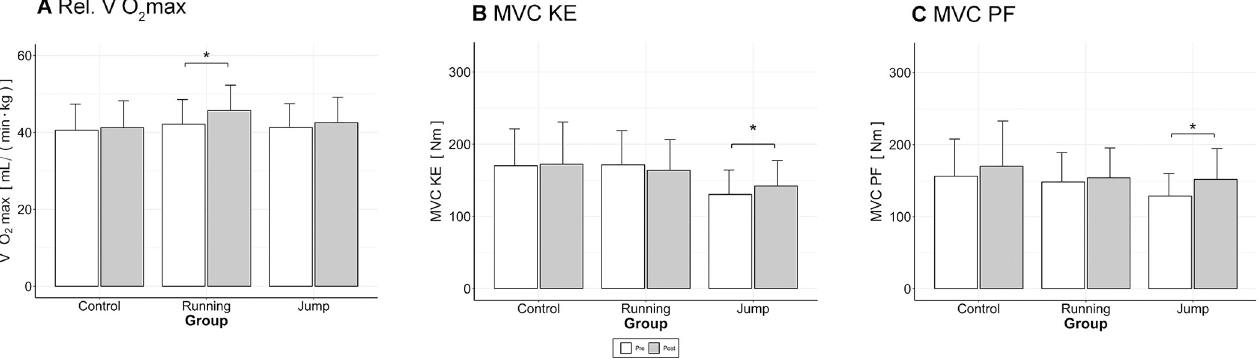
Fig 3. Changes in aerobic capacity as well as lower extremity strength. Results of the pre-tests in white, and post-tests in grey; data refer to group mean and SD. (A) relative _ V _ O , (B) Maximal voluntary contraction (MVC) during knee extension (KE), (C) MVC during plantar flexion (PF). The � symbols denote 2 max significant differences between pre-and post-values (Bonferroni-corrected post hoc